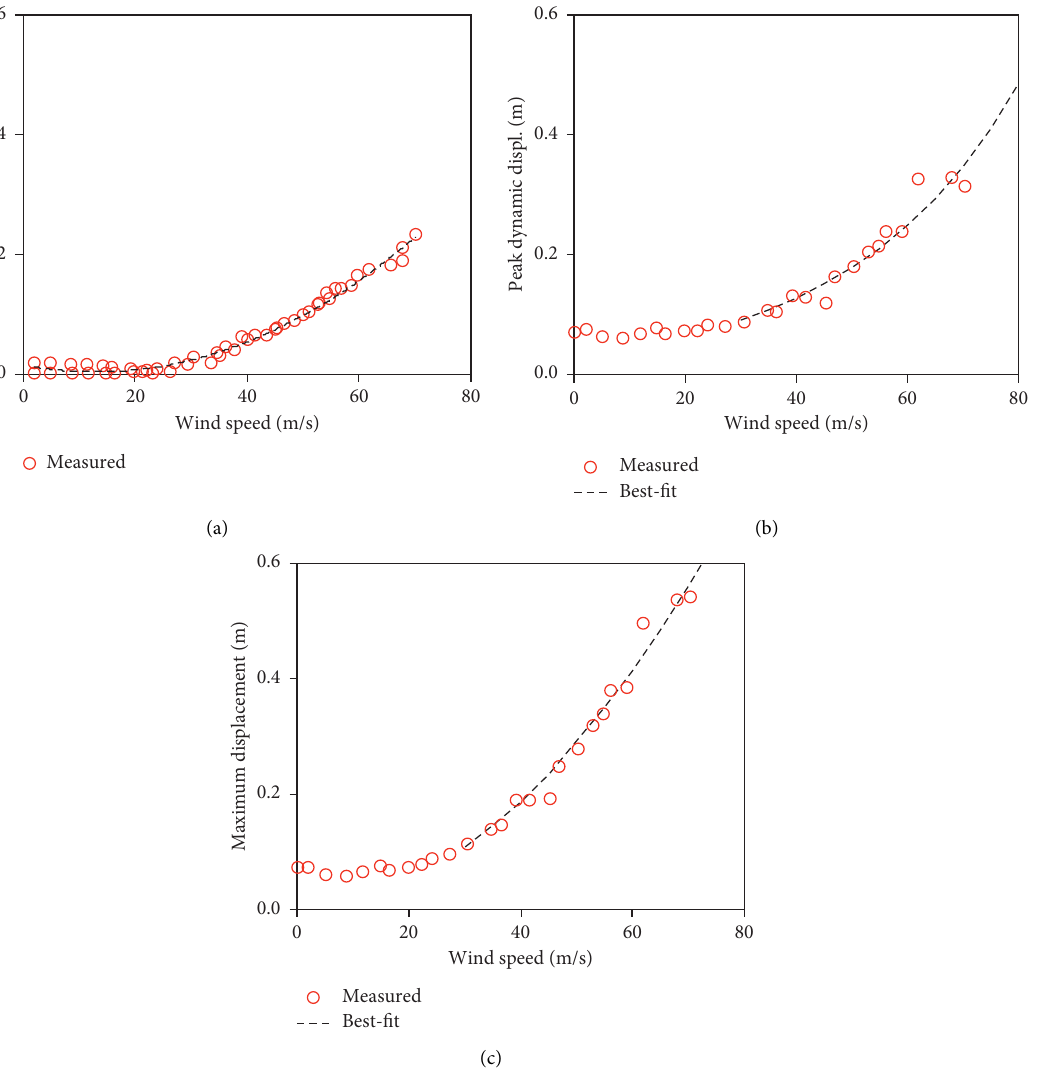
Figure 12: Along-wind displacements at tower top. (a) Static displacement. (b) Peak dynamic displacement. (c) Maximum